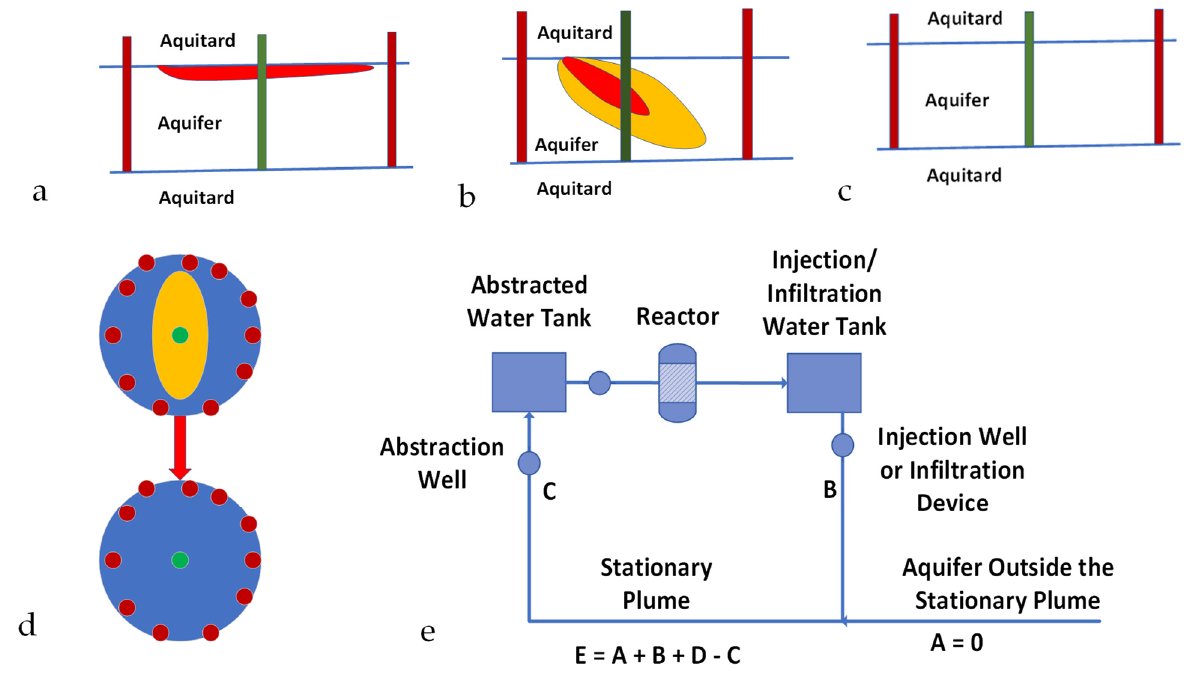
Figure A1. Hydrodynamic Stationary Plume Remediation. The hydrodynamic plume is defined by a volume separated by two or more injection wells containing an abstraction well; Green = abstraction well; Brown = injection/infiltration wells. ( a ), Light immiscible liquid plume (red); ( b ), Soluble ion or miscible liquid plume (red, orange); The contaminant plume occupies a fraction of the stationary plume volume; ( c ), Aquifer containing a natural contaminant, e.g., NaCl, As, etc.; ( d ), Plan view of a hydrodynamic stationary plume, showing removal of the pollutant plume (orange) over time; ( e ), Process flow diagram, which is designed to create a decontaminated hydrodynamic stationary